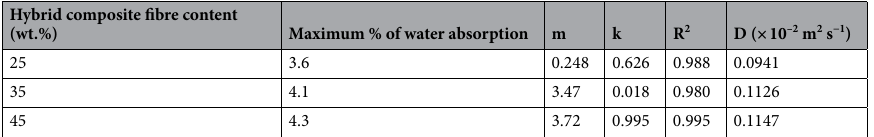
Table 3. Maximum percentage of water absorption and diffusion coefficients for all CGF/AFF/PF hybrid composites.